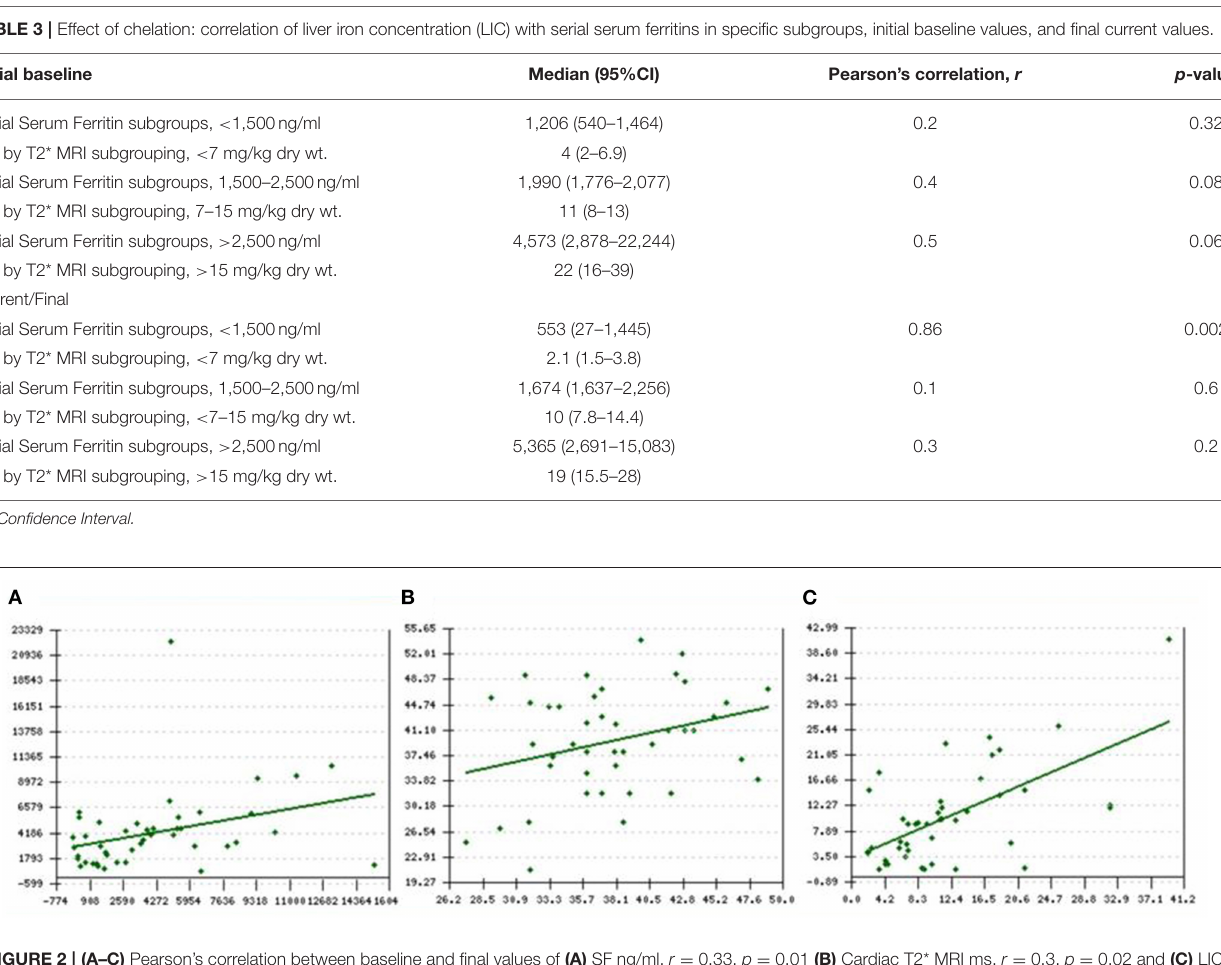
FIGURE 2 | (A–C) Pearson’s correlation between baseline and final values of (A) SF ng/ml, r = 0.33, p = 0.01 (B) Cardiac T2* MRI ms, r = 0.3, p = 0.02 and (C) LIC T2* MRI mg/kg dry weight, r = 0.6, p < 0.001. X-axis represents the baseline levels of respective parameters vs. y-axis which represents the final/current levels of the same parameter. SF, serum ferritin; LIC: liver iron